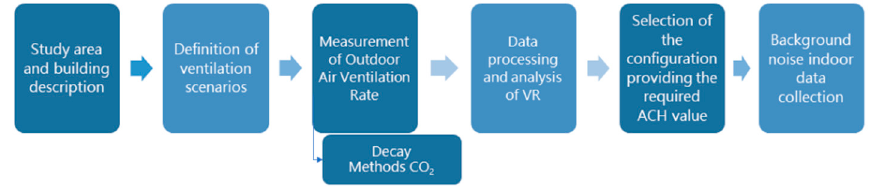
Figure 1. Diagram of the study’s methodological approach.